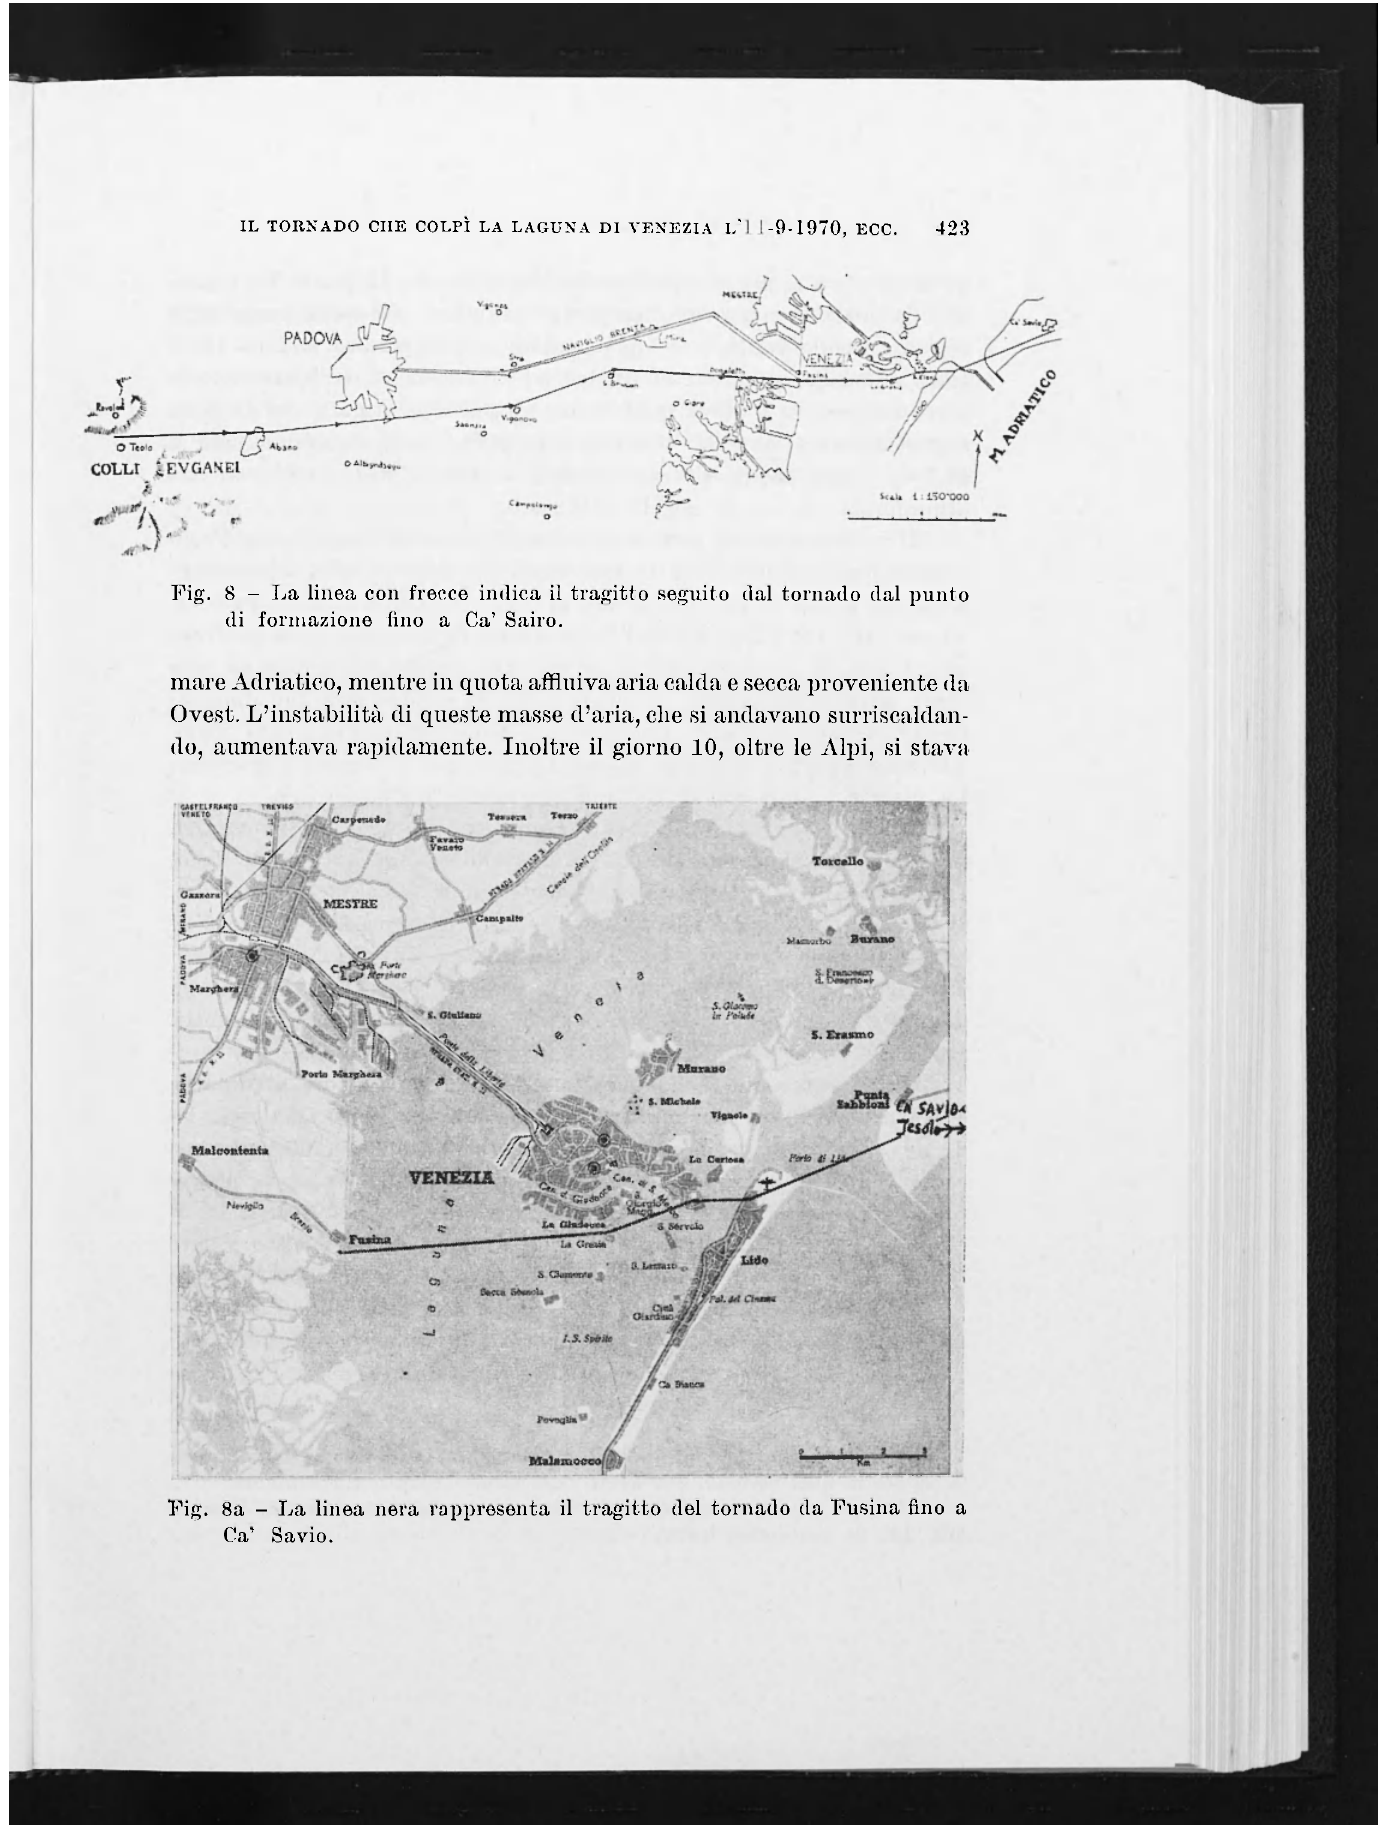
Fig. 8a - La linea nera rappresenta il tragitto del tornado da Fusina fino a Ca'